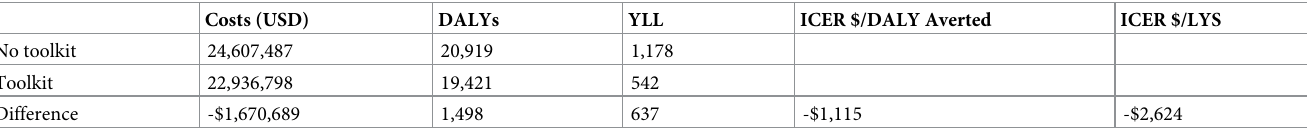
Table 3. Incremental cost-effectiveness